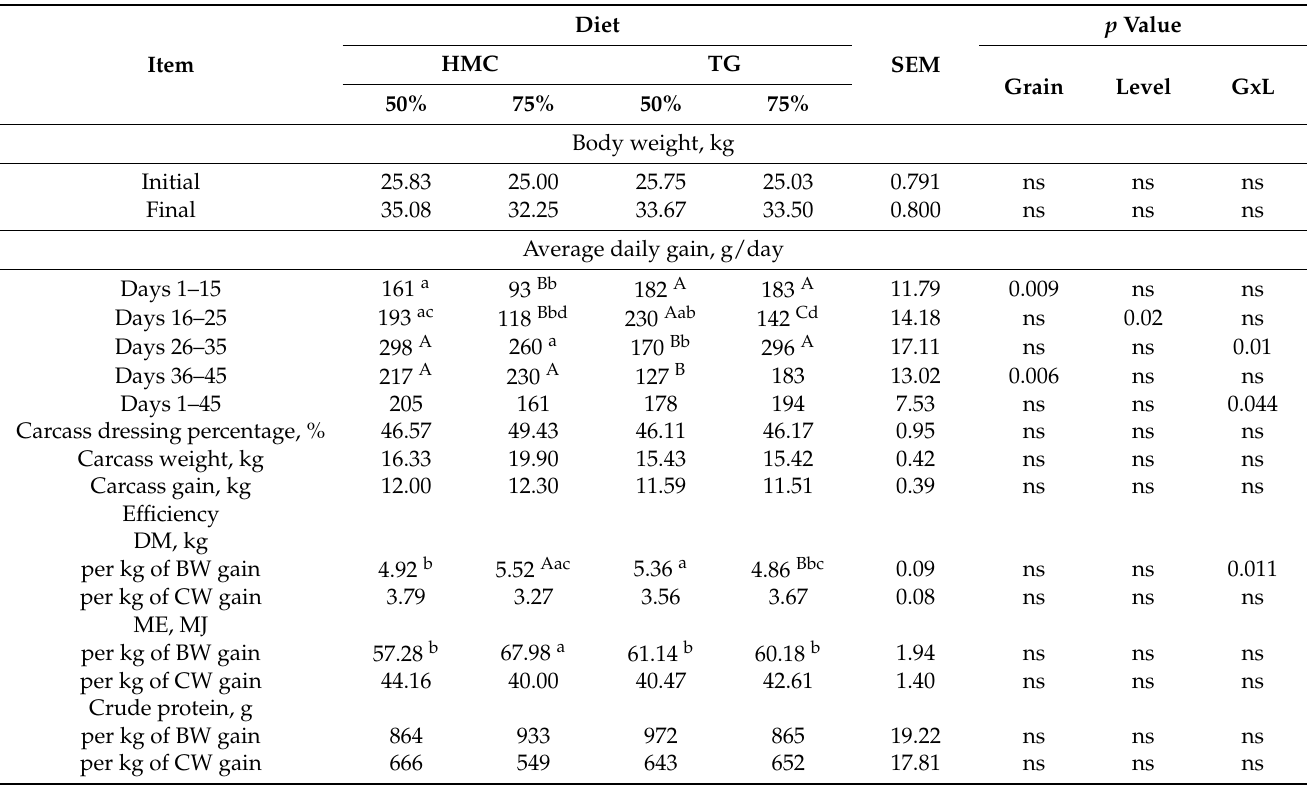
Table 4. Selected performance parameters in